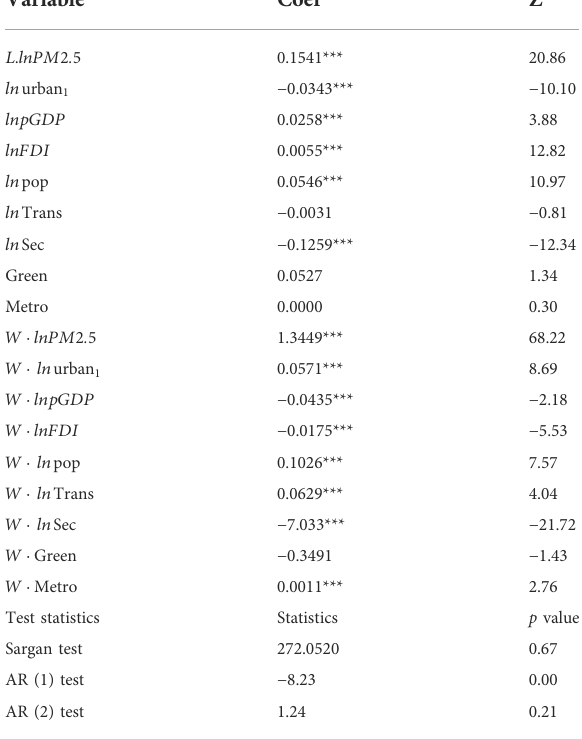
TABLE 6 Regression results based on systematic